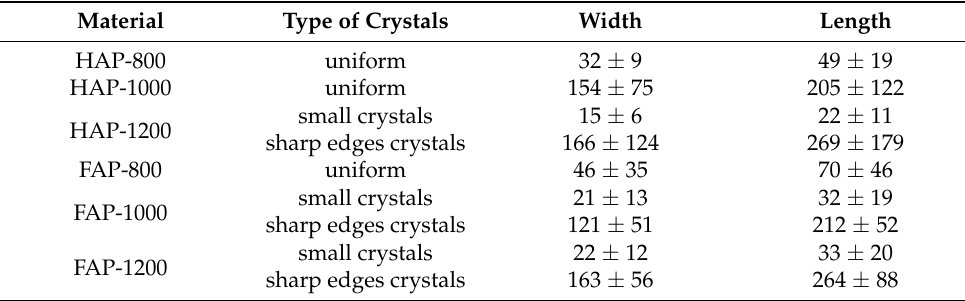
Table 2. Mean crystal size (nm) of HAPs and FAPs samples calculated by TEM.